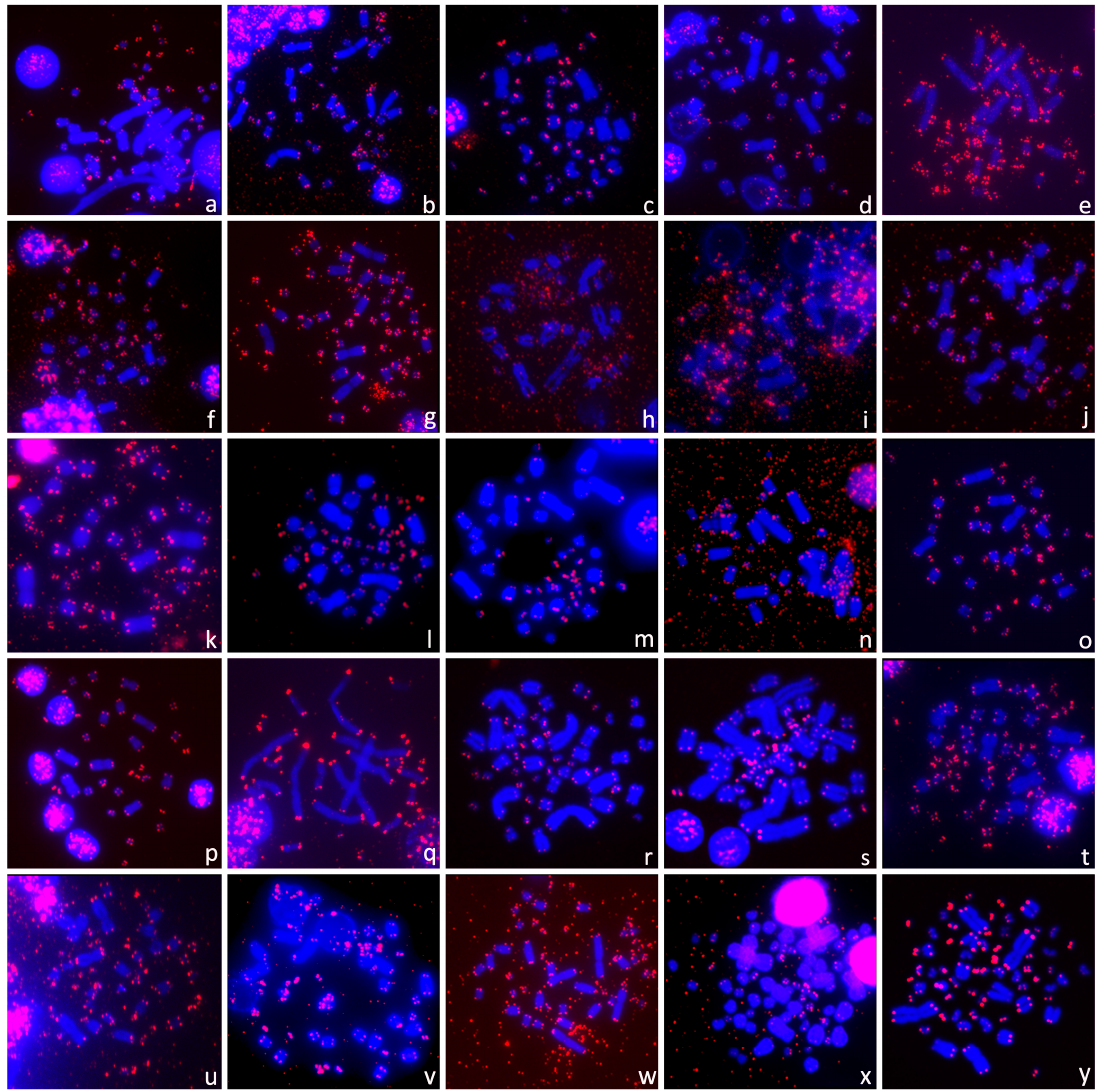
Figure 4. Thetelomeric(TTAGGG) n repeatsweredetectedonlyinterminalpositionsin( a ) Carettochelysinsculpta Figure 4. The telomeric (TTAGGG) n repeats were detected only in terminal positions in ( a ) (Carettochelyidae),( b ) Emydurasubglobosa ,( c ) Mesoclemmyshogei (bothChelidae),( d ) Graptemyspseudogeographica Carettochelys insculpta (Carettochelyidae), ( b ) Emydura subglobosa , ( c ) Mesoclemmys hogei (both Chelidae), ( d ) Graptemys pseudogeographica , ( e ) Trachemys decussata (both Emydidae), ( f ) Cyclemys dentata , ( g ) Cyclemys pulchristriata , ( h ) Hardella thurjii , ( i ) Heosemys depressa , ( j ) Leucocephalon yuwonoi ,